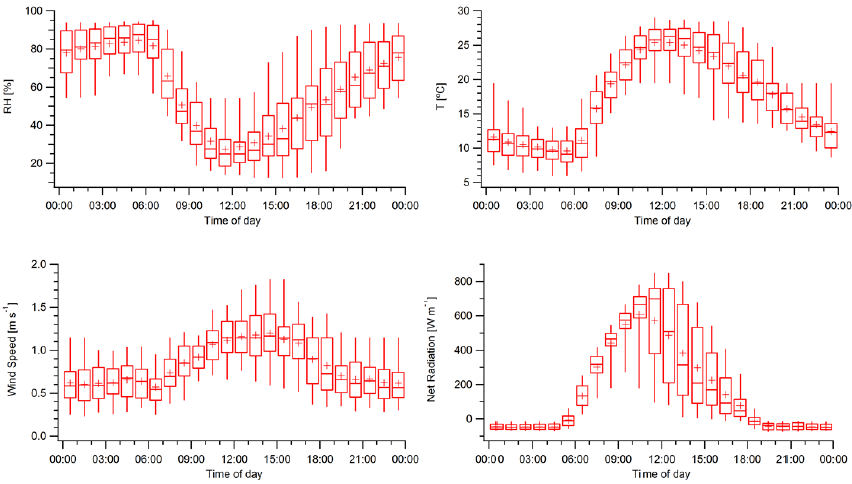
Fig. 1. Average diurnal cycles of (a) Relative Humidity, RH (%), (b) Temperature ( ◦ C), and (c) Wind speed (m s − 1 ) (d) net radiation (W m − 2 ), all recorded at 2 m next to the WIBS-3 during the experiment. Data is binned into 1 hour intervals. Time reported as Mountain Standard Time (MST).